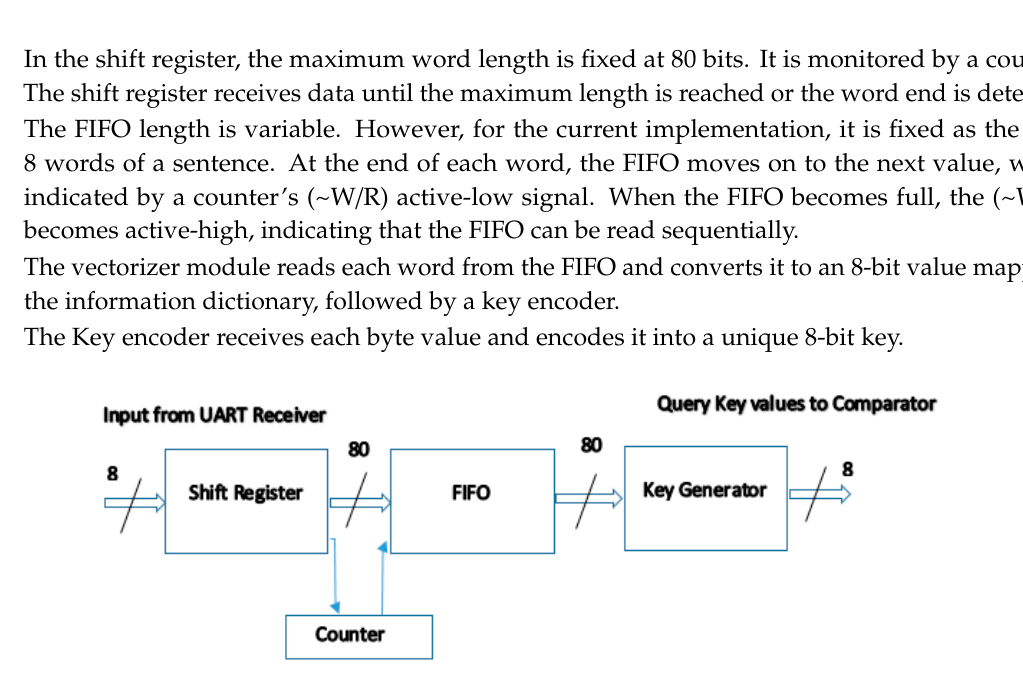
Figure 5. Vectorizer module.